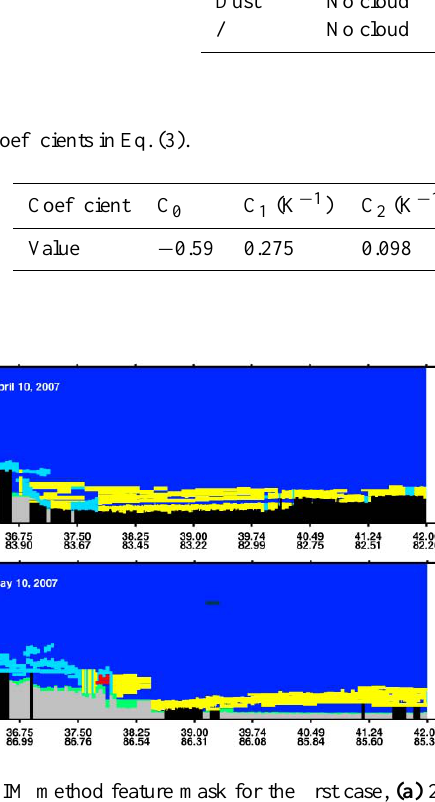
Fig. 7. Table 2 selection of cloud (blue bar) and dust aerosol (red bar) vs. V2-CAD method Feature Classification (feature type: 2=cloud, 3=aerosol) for spring